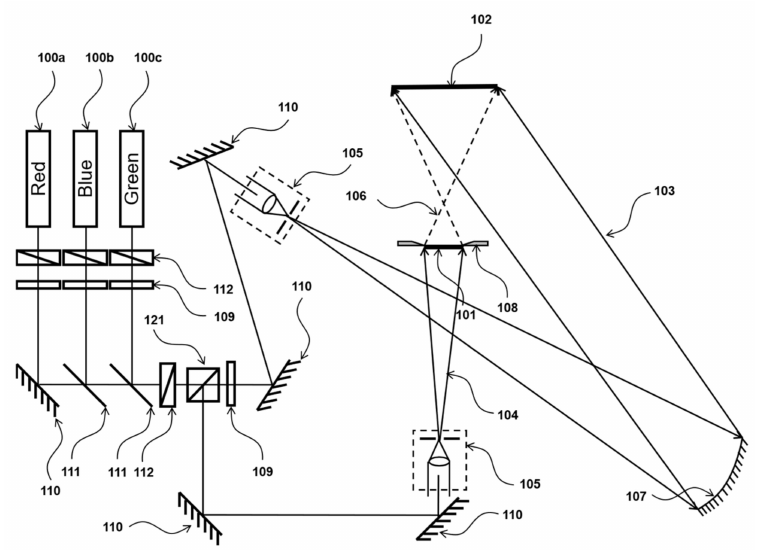
Figure 1. Schematic view of the P-HOE two-beam recording